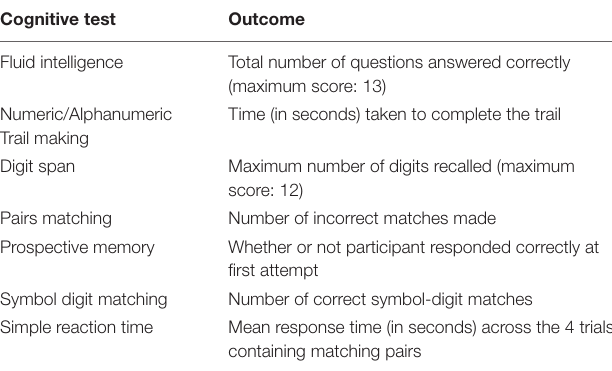
TABLE 1 | Neuropsychological tests of the UK Biobank battery examined in the present study. Cognitive